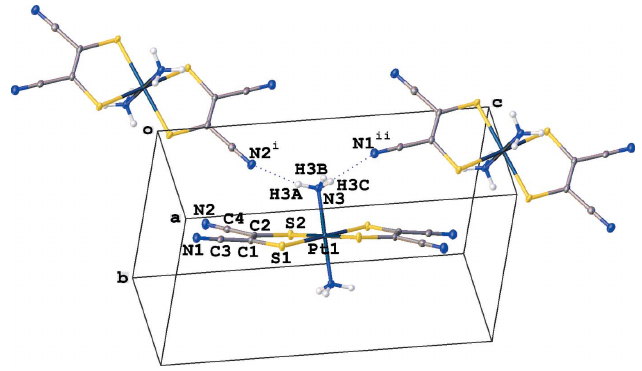
Figure 1 Displacement ellipsoid plot 50% probability of all non-H atoms showing N—H hydrogen bonding between nitrile nitrogen atoms and hydrogen atoms on adjacent ammines. Symmetry codes: (i) (cid:2) x , y (cid:2) 1 (cid:2) y + 1 , z + 1 2 2